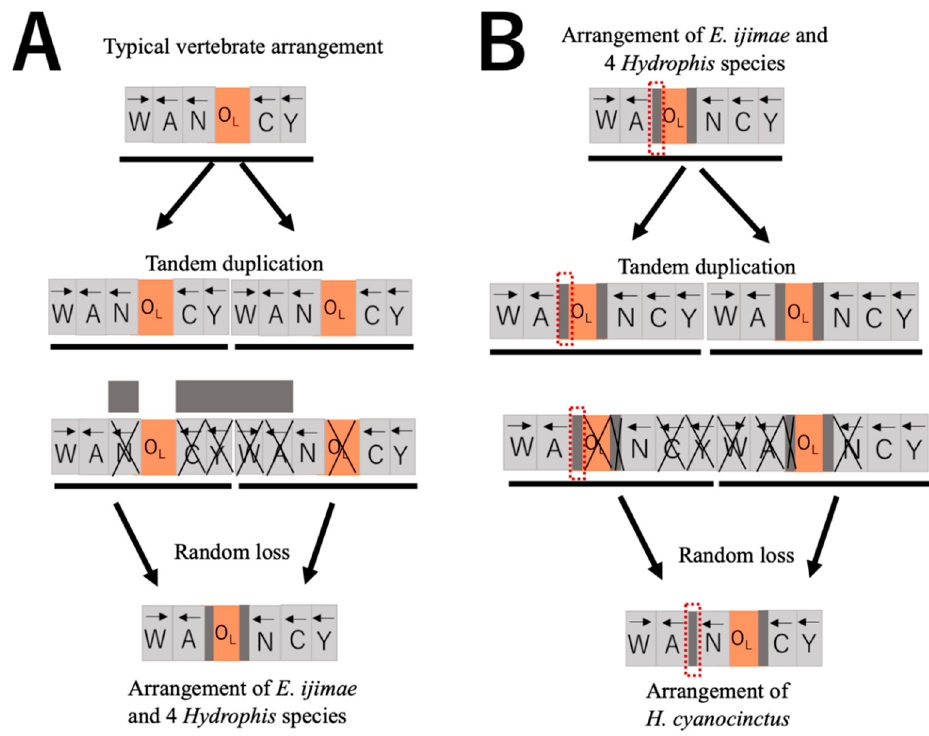
Figure 5. Plausible pathways for the O L translocation ( A ) and its reversal ( B ) by the Tandem Duplication—Random Loss model [47]. X shows genes and O L randomly chosen to be deleted by the model. Gray boxes show intergenic spacer sequences and an intergenic region circled by red dots includes nucleotide sequences with sequence similarity among all 5 Hydrophis species and E. ijimae (Figure